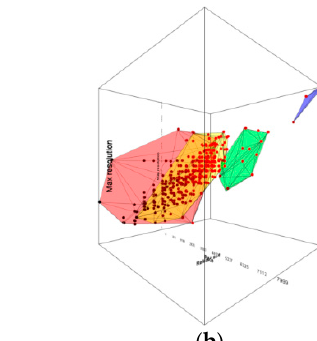
( c ) Figure 45. Visualization of London resident-mobility data [120]: ( a ) original flows; ( b ) filtered flows